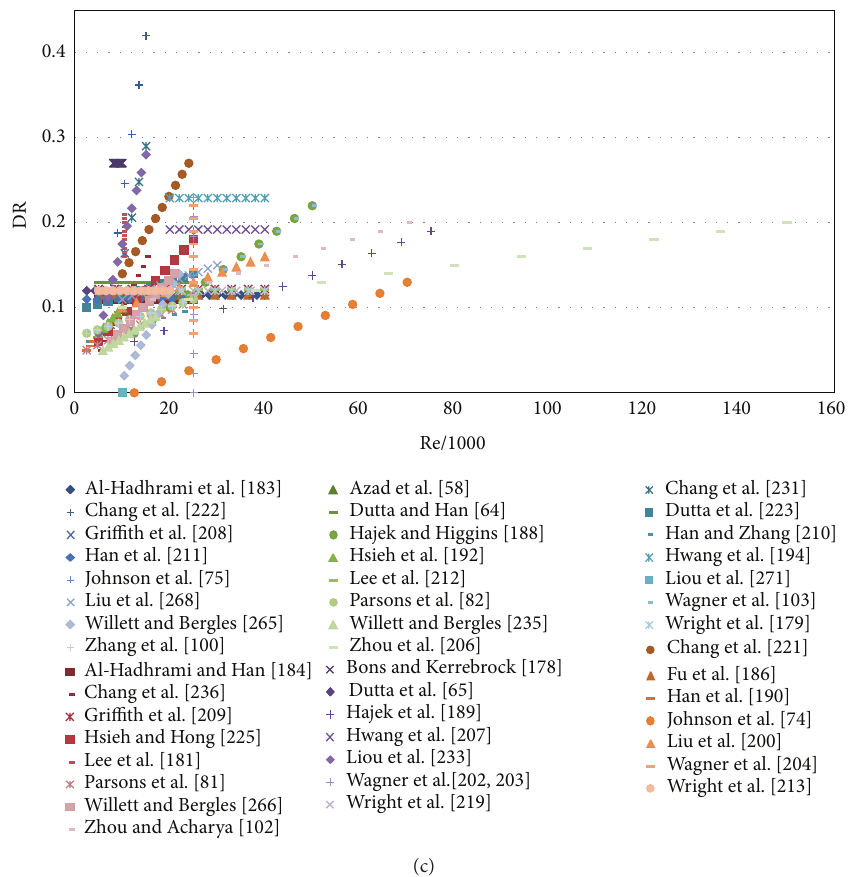
Figure 29: Ranges of experimental parameters for existing investigations of channel flows with rotation. (a) Rotation number versus Reynolds number. (b) Buoyancy parameter versus Reynolds number. (c) Inlet density ratio versus Reynolds